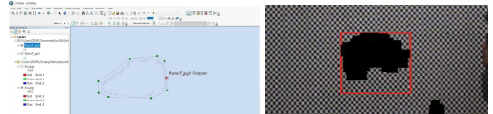
Figure 7. Frame Converted from Raster to Vector using ArcMap (left) and Frame wherein the Smoke Extent was Highlighted (right)